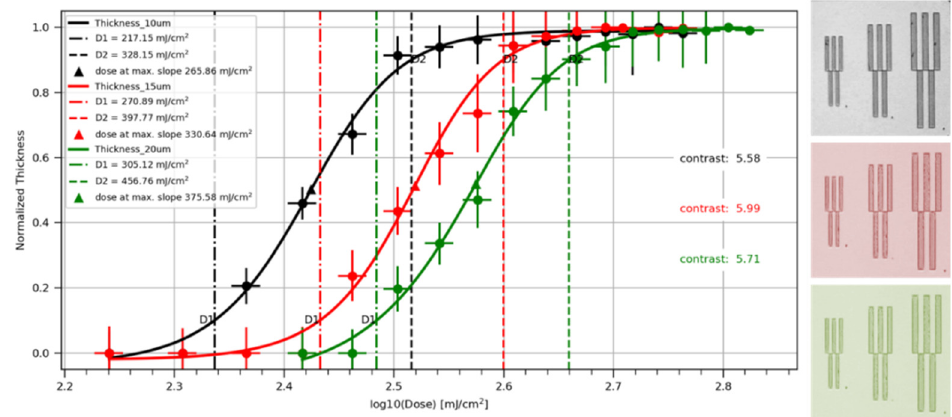
Figure 1. Sensitivity curves obtained for mr ‐ X 10 photoresist layers of thickness: 10 μ m (black), 15 μ m (red), 20 μ m (green), and the respective colored pattern overview for 10 μ m (gray), 15 μ m (red), and 20 μ m (green). The curves were plotted using the approach reported in [18]. In the figure, contrast values for different curves are defined according to Equation (2). The dose at the maximum slope serves as a quantitative value for a comparison of the curves’ shift.